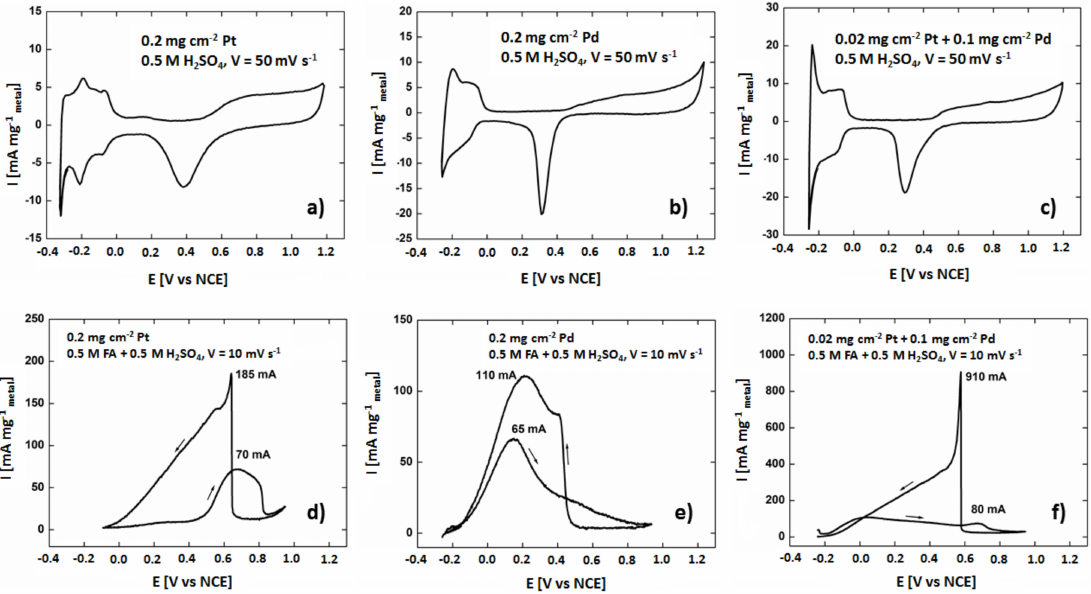
Figure 6. Cyclic voltammograms of the ( a , d ) 0.2 mg cm − 2 Pt / TiO 2 NT, ( b , e ) 0.2 mg cm − 2 Pd / TiO 2 NT, ( c , f ) 0.1 mg cm − 2 Pd + 0.02 mg cm − 2 Pt / TiO 2 NT catalysts modified electrodes recorded in 0.5 M H 2 SO 4 and 0.5 M H 2 SO 4 + 0.5 M HCOOH. Table 1. Average electrochemically active surface area for samples investigated